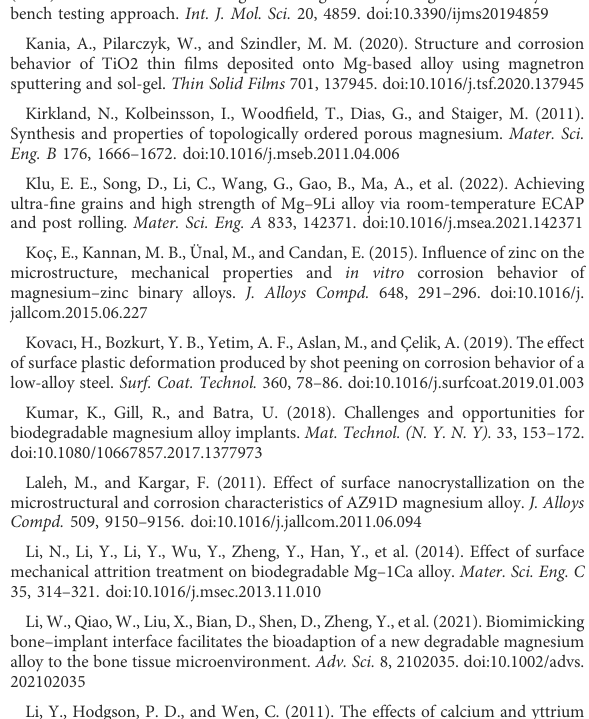
Figueira,R.B.,Fontinha,I.R.,Silva,C.J.,andPereira,E.V.(2016).Hybridsol-gel coatings: Smart and green materialsfor corrosion mitigation. Coatings 6,12.doi:10. 3390/coatings6010012 Figueira, R. B. (2020). Hybrid sol – gel coatings for corrosion mitigation: A critical review. Polymers 12, 689.